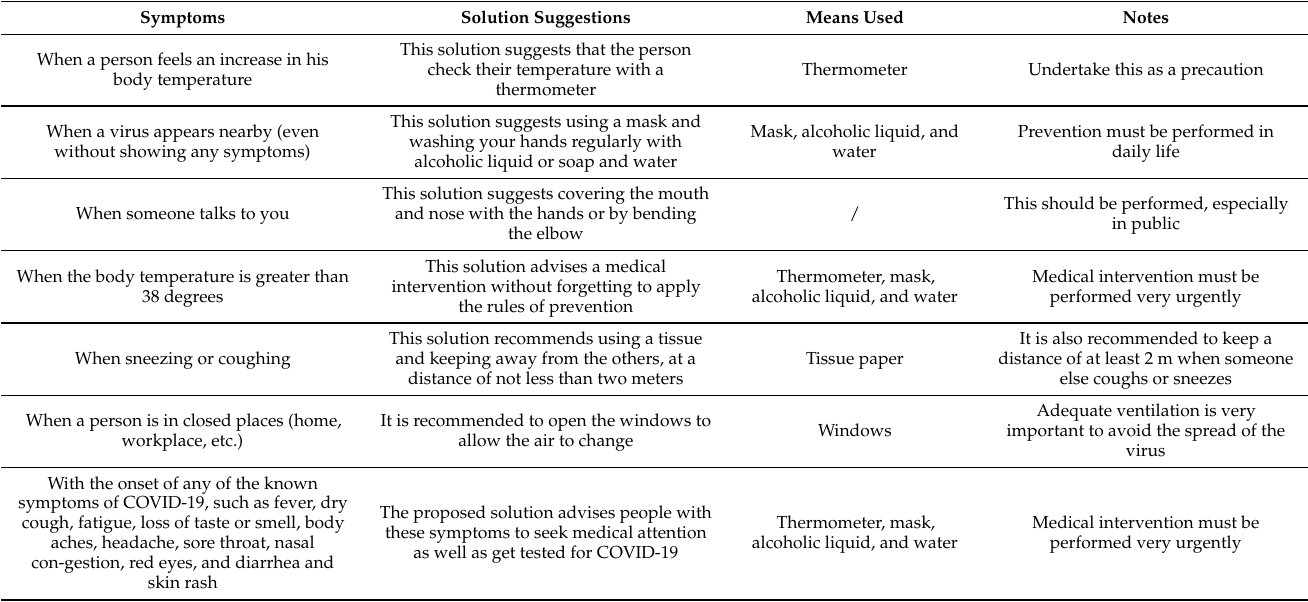
Table 7. Description of the